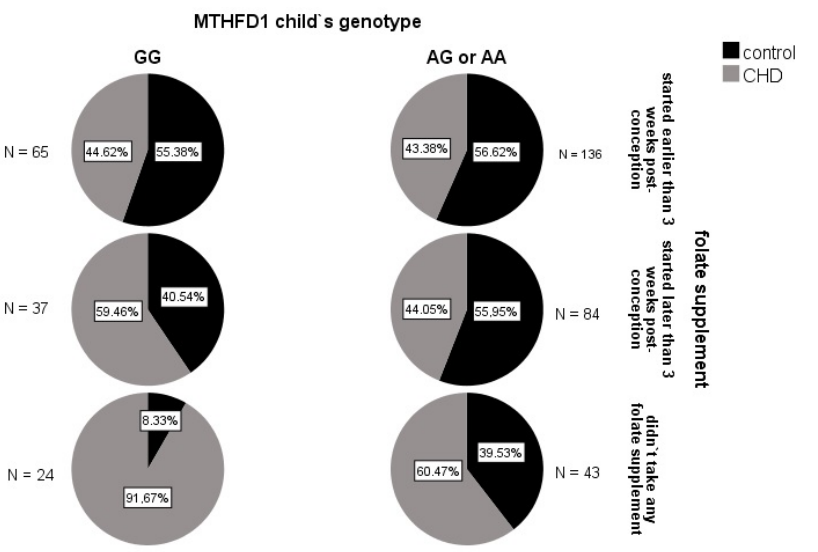
Figure 2. Incidence of CHD in the subgroups of the children, according to MTHFD1 genotype and maternal folate supplementation in early pregnancy. The highest incidence of CHD (91.7%) was seen for the MTHFD1 rs2236225 GG children whose mothers did not take any folate supplements. In contrast, the lowest incidences (~44%) were seen for the children of mothers who started folate intake early, irrespective of the MTHFD1 genotype, and in the MTHFD1 AG/AA children of mothers who started folate intake later than 3 weeks post conception.